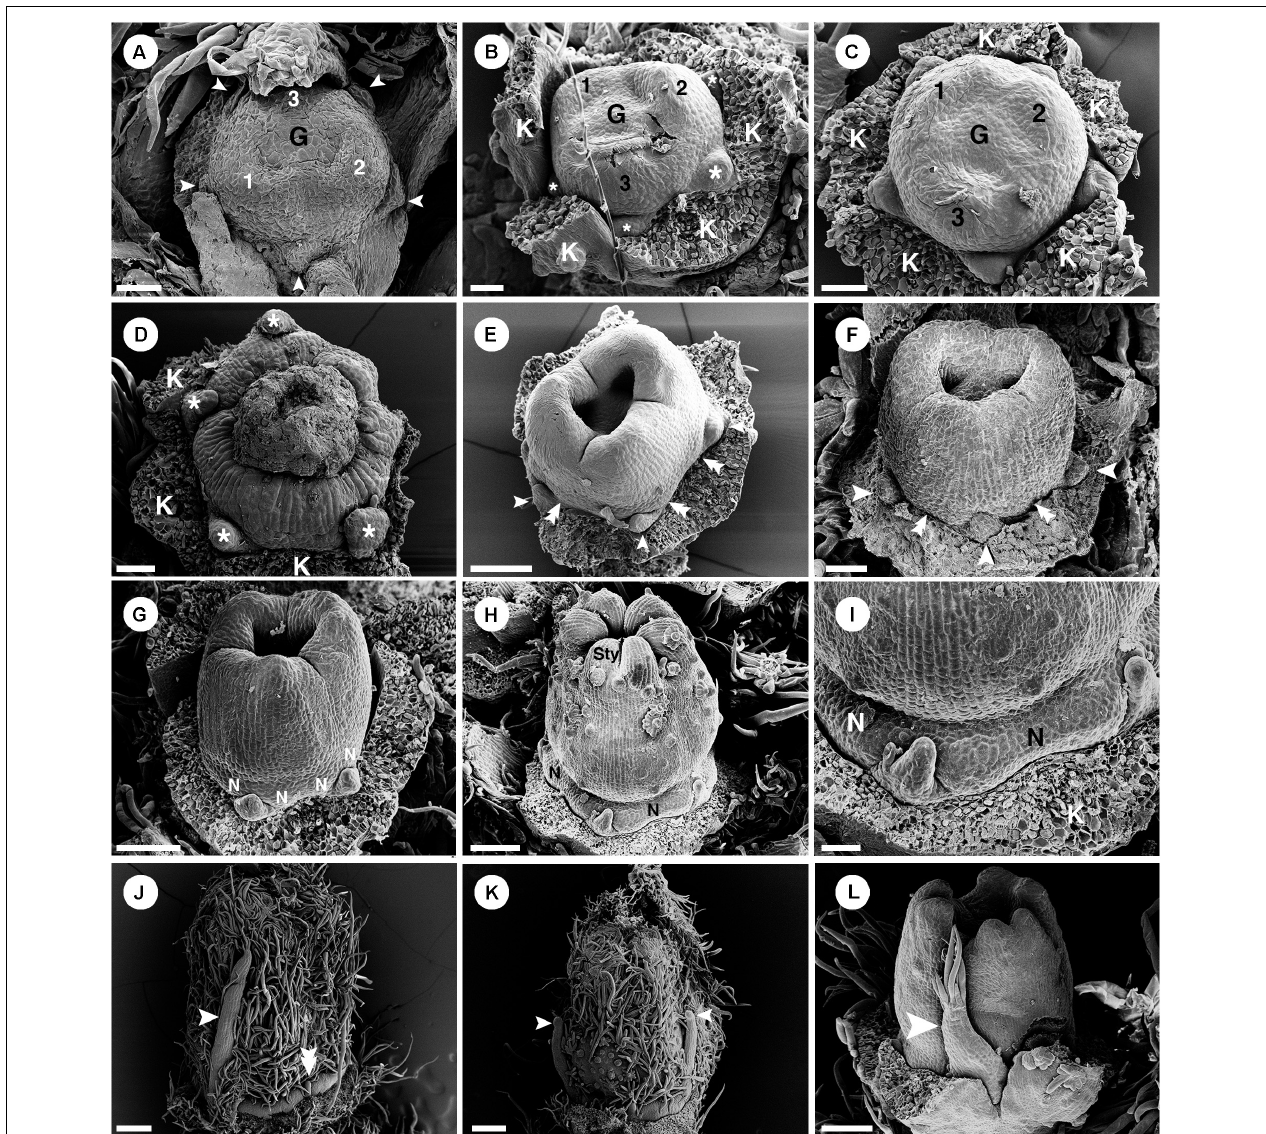
FIGURE 6 | Ontogeny of pistillate flowers of Croton chilensis . (A) A young flower shows initiation of petal-like primordia (arrowhead) and formation of an ovary by fusion of three carpels. (B) Petal-like primordia (asterisk) are arranged alternating with sepals. (C) Petal-like organs show slight differences in growth. (D) Flower with aborted ovary. Petal-like organs clearly show unequal growth (asterisk). (E) Later, three carpels close apically while petal-like organs development is arrested (arrowhead). Nectary primordia start to initiate at the base of the ovary (double arrowhead). (F) Petal-like organs stop their development while the ovary grows and expands in size (arrowhead). Nectary tissue starts to form at the base of the ovary opposite to sepals (double arrowhead). (G) Later stage; a bilobed style is formed on top of each carpel. Nectary glands appear to be bilobed by pressure of the sepal lobes. (H) Next, a bifid style can be seen on top of each carpel. Nectariferous tissue expands to become a ring. (I) Magnified view of the previous picture shows the nectary ring expansion while petal-like organs are still minute. (J) Later, some petal-like organs grow into filamentous structures (arrowhead) while some are still arrested in their development (double arrowhead). (K) Some filamentous structures have a tendency to become a colleter (arrowhead). (L) A miniature petal is sometimes present by extension of the petal-like organs (arrowhead). G, ovary; K, sepal; N, nectary; Sty, style. Numbers on the gynoecium in (A–C) indicate carpel number. Scale bars: (A,B,I) = 40 µ m; (C,D,F) = 50 µ m; (E,G,L) = 100 µ m; (H) = 120 µ m; (J,K) = 200 µ